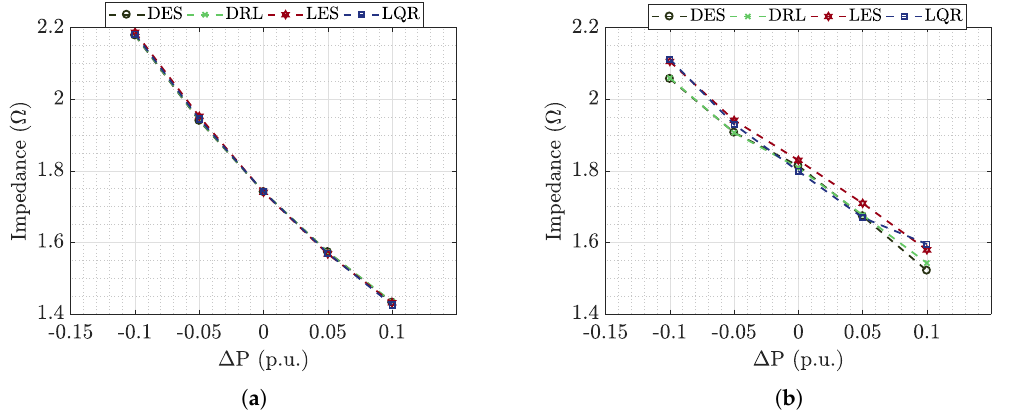
Figure 32. Impedance of the feeder buck in time during the ( a ) simulation and ( b )